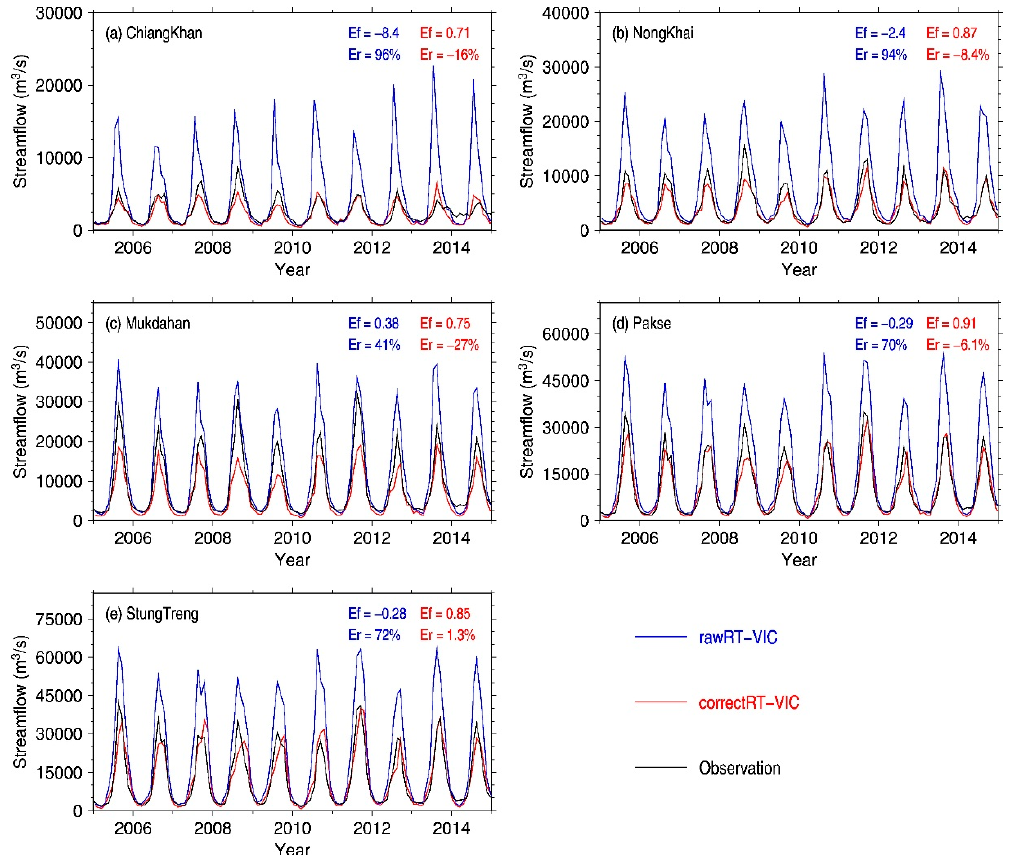
Figure 8. Comparisons of VIC-simulated monthly streamflow driven by the TMPA and NCEP-NCAR RT forcings (Raw and Corrected) against in situ observations during the 10-year validation period (2005–2014) at five hydrological stations. ( a ) Chiangkhan; ( b ) NongKhai; ( c ) Mudahan; ( d ) Parkse; ( e ) StungTreng.